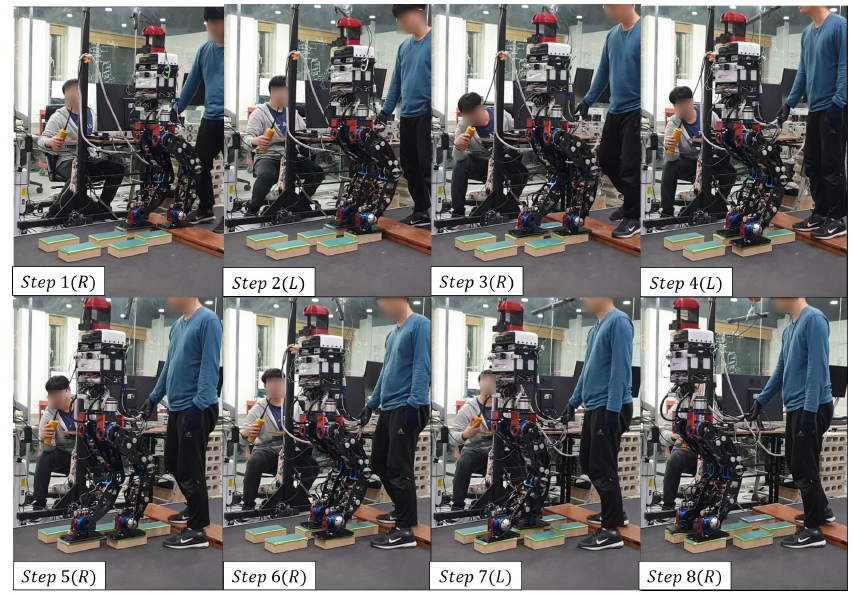
Figure 17. The experiment of Scene